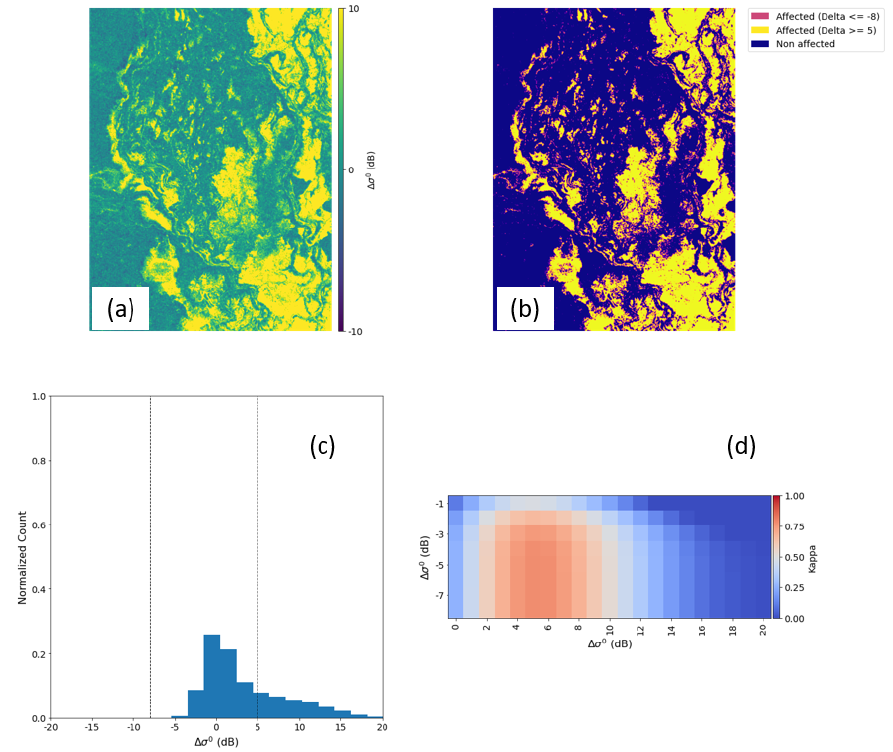
Figure 13. Mozambique ConvLSTM Delta image of VH polarization ( a ), Flood Proxy Map ( b ), Histogram of Delta image ( c ), and Cohen’s Kappa heatmap ( d ).